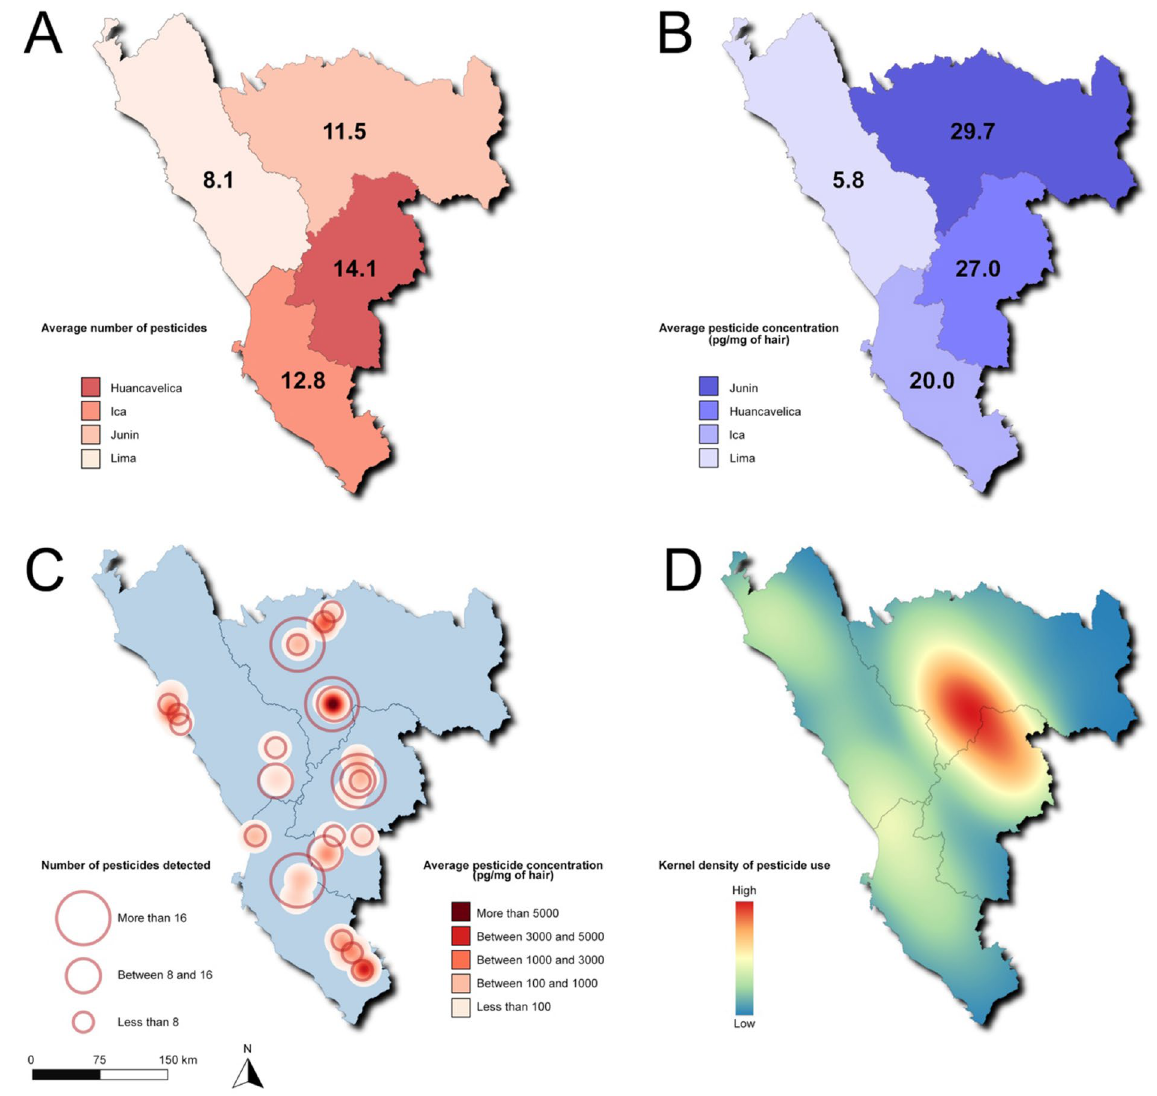
Figure 4. Spatial distribution of pesticide contamination among Peruvians from the Central Andes. ( A ) Choropleth map showing the average number of pesticides per subject according to their home department (red shades). ( B ) Choropleth map showing the average pesticide concentration (pg/mg of hair) per subject according to their home department (blue shades). ( C ) Proportional symbol map showing the spatial distribution of the subjects ( N = 50). Circle area and color intensity (red shades) denote the number and the concentration of contaminating pesticides in hair samples, respectively. ( D ) Kernel density map showing pesticide use in the Central Andes of Peru, according to the 2019 National Agricultural Survey. Colors indicate the gradient in pesticide use intensity ranging from blue (low) to red